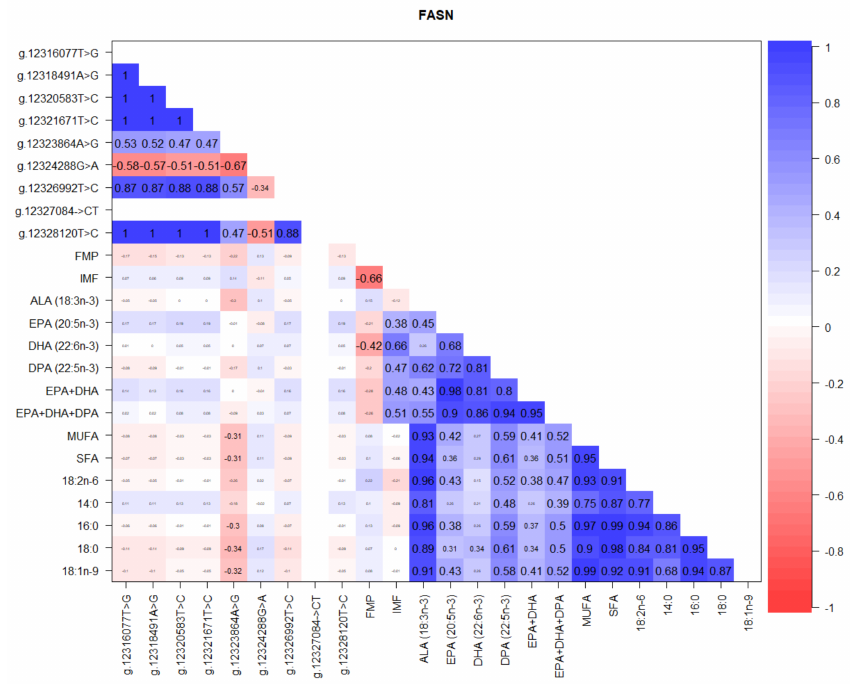
Figure 8. Correlations between FASN gene SNP loci, IMF, FMP, and fatty acids in TAW